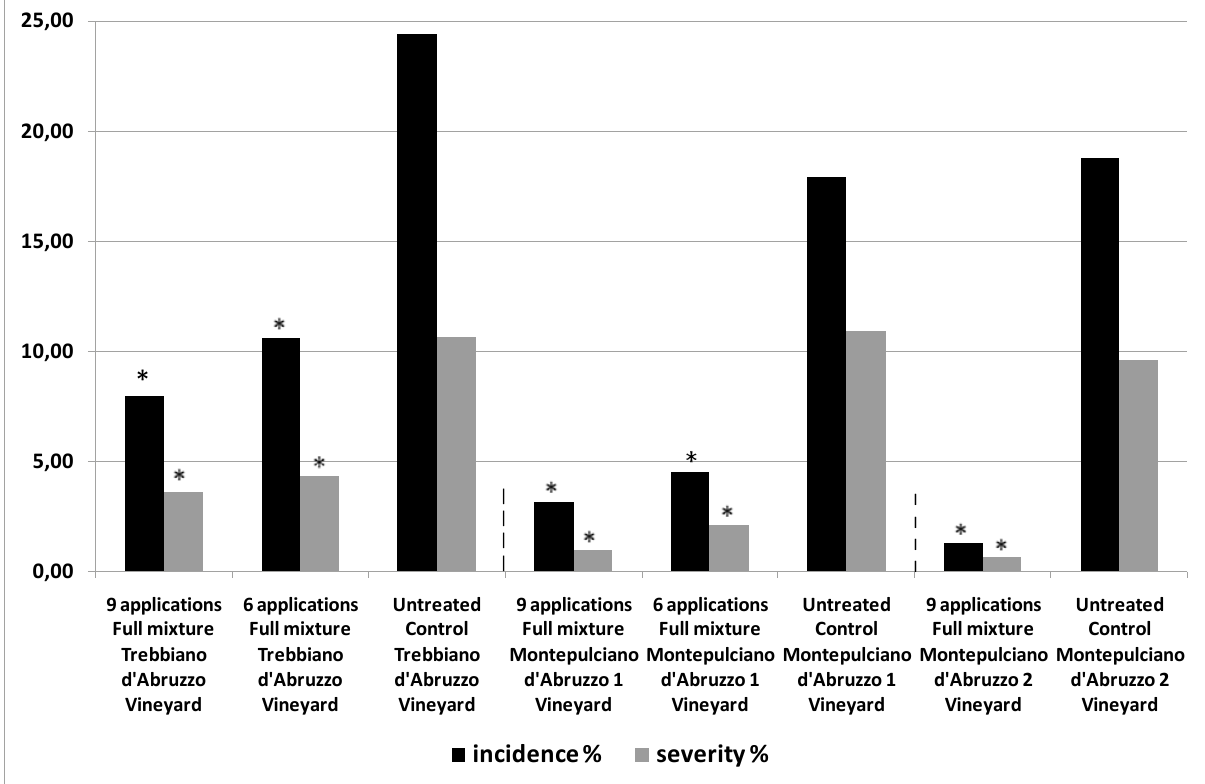
Figure 1. Mean incidence and severity of GLSD leaf symptoms in a Trebbiano d’Abruzzo and two Montepulciano d’Abruzzo vineyards, after applications of the mixture of CaCL 2 , Mg(NO 3 ) 2 and seaweed extract in 2013. Chi-square statistics com- pared the full mixture treatments to the untreated controls in three trials. In the Trebbiano d’Abruzzo and Montepulciano d’Abruzzo 1 vineyards, the nine applications treatment was also statistically compared with the six applications treatment. For symptom incidence or severity, * indicates statistically significant differences ( P < 0.05) between treatments. Bars la- belled with the same symbol are not statistically